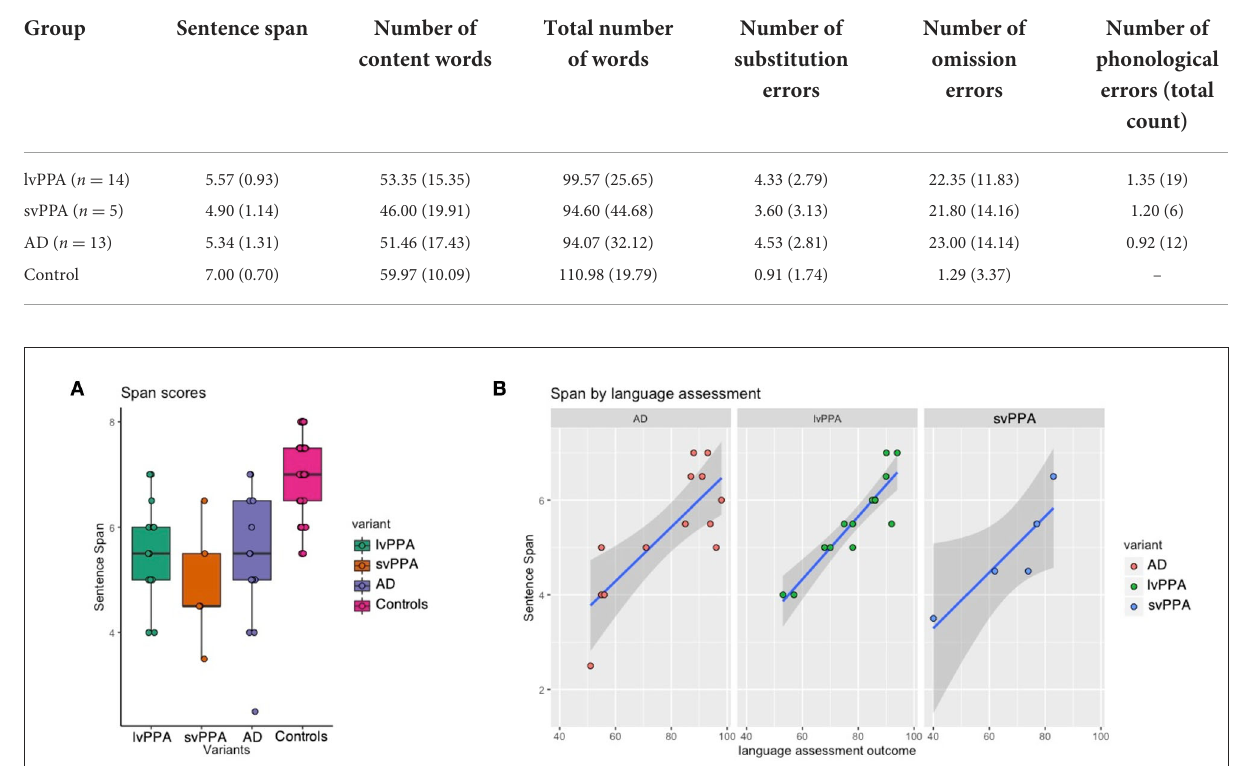
TABLE 2 Participants’ sentence repetition span task performance outcomes in means; standard deviations are given in parenthesis. Group Sentence span Number of